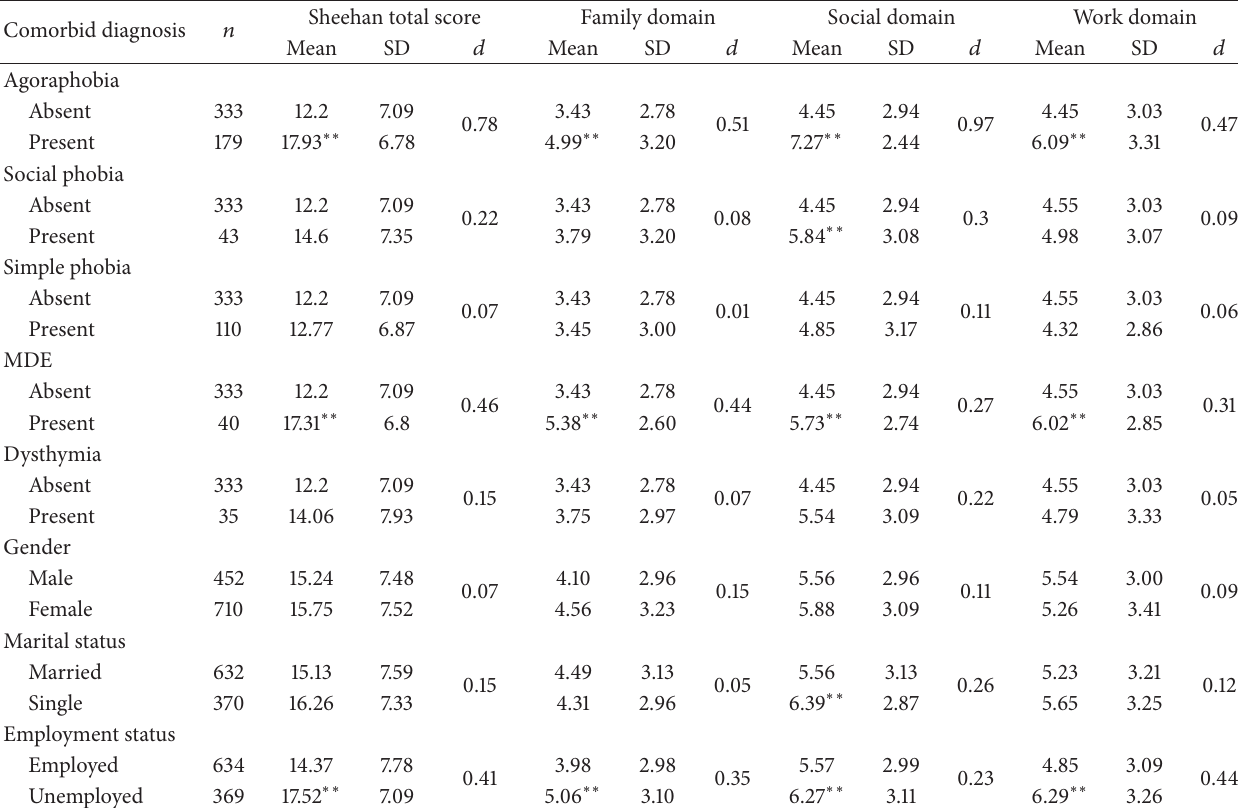
Table 1: 𝑡 -test results of comorbid conditions and